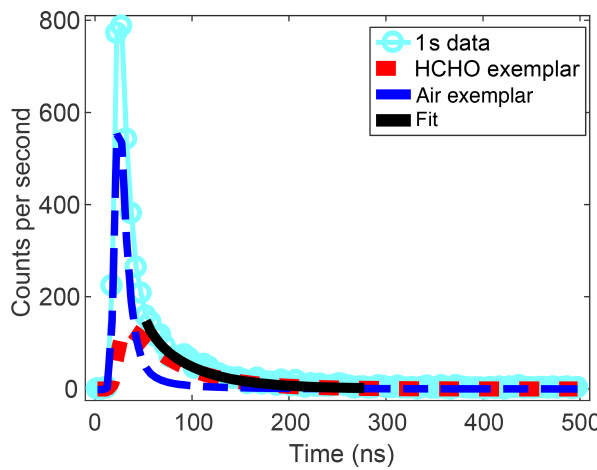
Figure 5. An example of a 1Hz, 5ns binned time profile (cyan cir- cles) for ∼ 10ppbv HCHO is fit using a two-parameter nonlinear least-squares approach. The two components of the fit are the scaled air (dashed blue line) and HCHO (dashed red line) contributions to the time profile. The fit, shown in black, is performed over a subset of the time